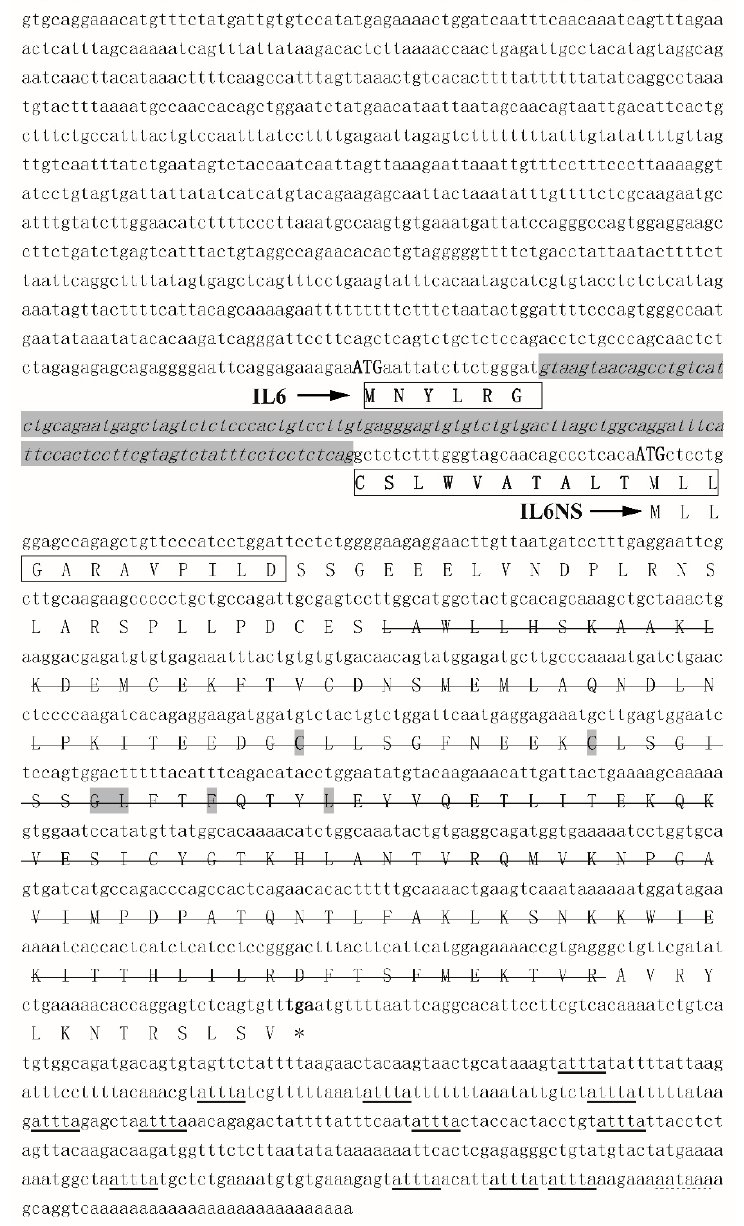
Figure 1. Nucleotide and deduced amino acid sequences of psIL6 and psIL6ns . Additional nucleotides of psIL6ns are in italic and shaded. Translation starting sites for psIL6 and psIL6ns are in uppercases. Signal peptide of psIL6 is boxed. The IL6-superfamily domain has a single strikethrough. The IL6/G-CSF/MGF family signature characteristic (C-X(9)-C-X(6)-G-L-X(2)-Y/F-X(3)-L) is shaded. Instability motifs (attta) are underlined and polyadenylation signal (aataaa) is above the dashed line.